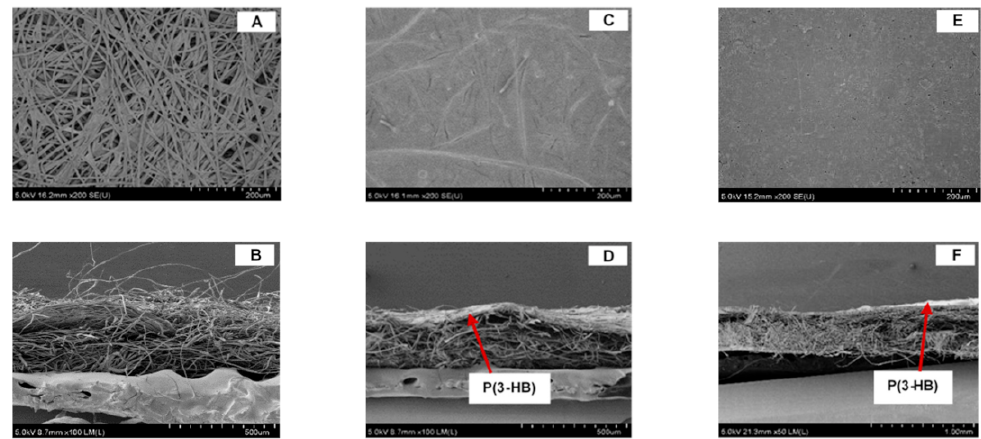
Figure 2. SEM micrographs of the surface and cross section of ( A , B ) the non-coated PLFP, ( C , D ) the commercial P(3-HB) coated PLFP at 7.5% ( w/v ) and ( E , F ) the biosynthesized P(3-HB) coated PLFP at 7.5% ( w/v